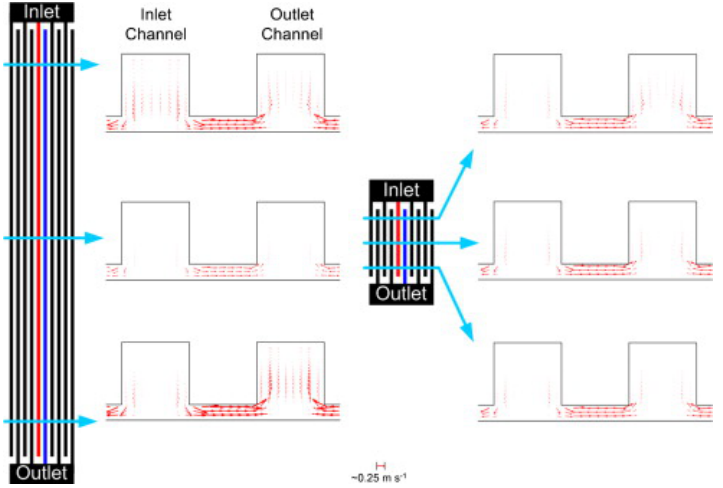
Figure 7. The cross-sectional views of cross flow velocity at x / L c positions of approximately 10%, 50%, and 90% of both long and short interdigitated flow channels [58].